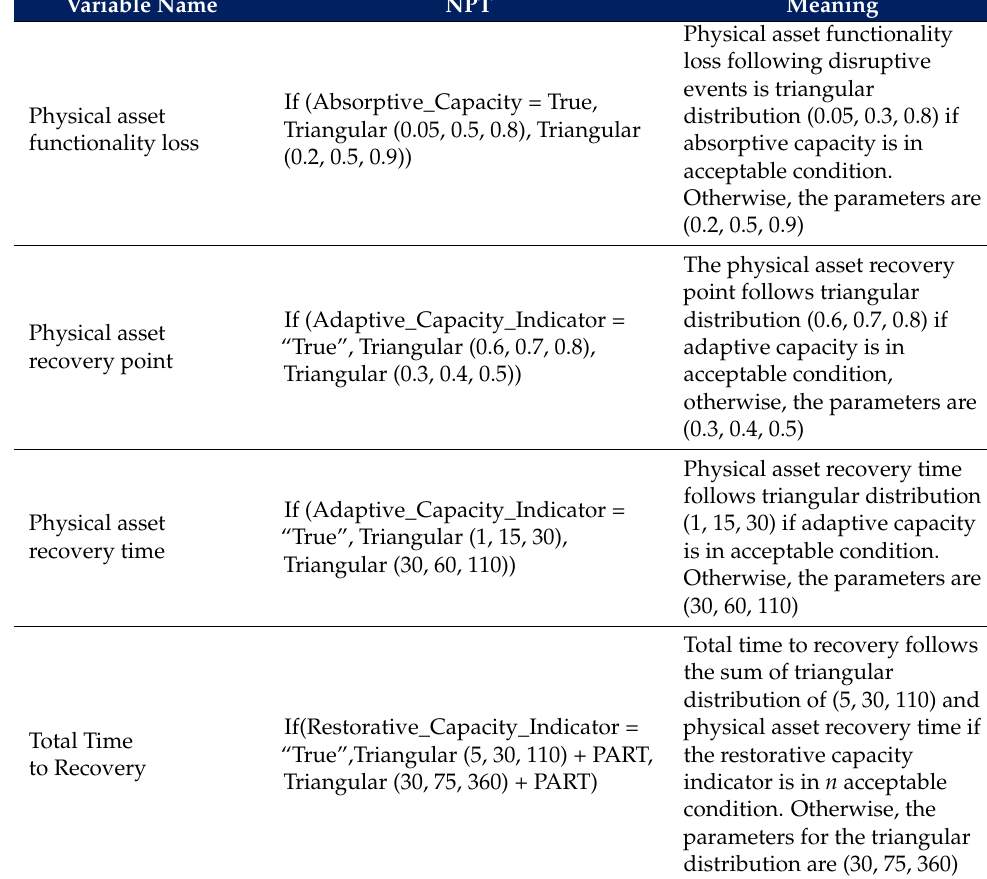
Table 9. NPT of the variables describing